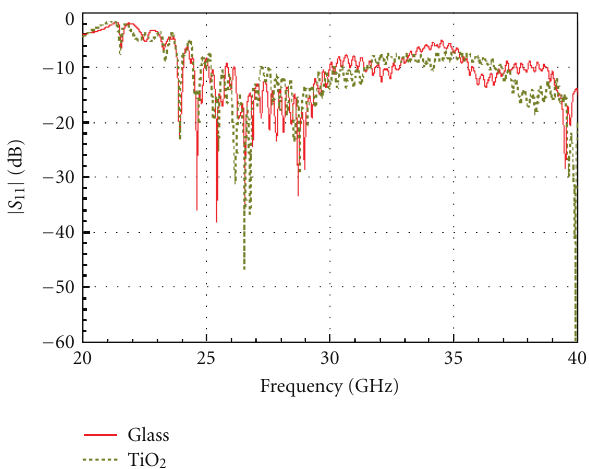
Figure 6: Reflection measurements of TiO 2 deposited glass and glass-only samples.